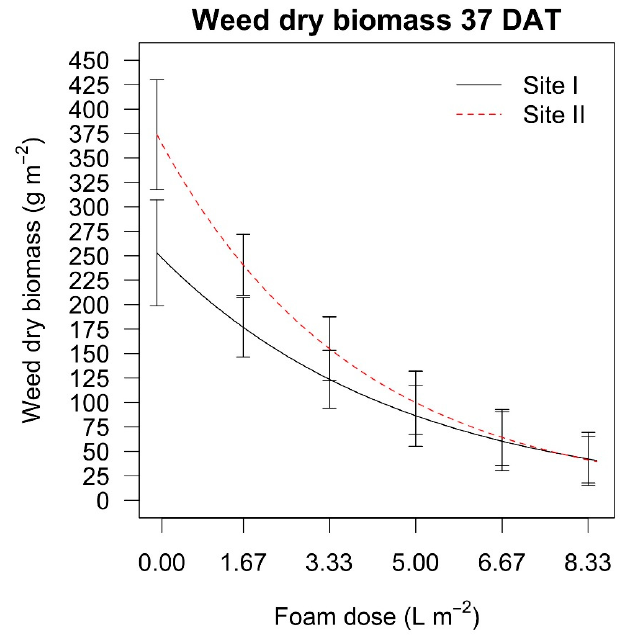
Figure 8. Exponential decay curves with 95% confidence interval bars of weed dry biomass collected 37 days after the treatment (37 DAT) as affected by the foam dose (0, 1.67, 3.33, 5.00, 6.67 and 8.33 L m -2 , respectively) and the site in the Taraxacum officinale (Weber) and Plantago lanceolata (L.) infested field experiment. The parameters and standard errors of the non-linear regression curves (Equation (3)) are: d = 253.02 (±26.659) and 373.88 (±27.614) for Site I and II, respectively; e = 4.66 (±0.957) and 3.78 (±0.543) for Site I and II, respectively. Table 8. Mean values and standard errors (SE) estimated from the exponential decay model (Equation (3)) of the weed dry biomass as affected by the different foam doses (0, 1.67, 3.33, 5.00, 6.67 and 8.33 L m -2 , respectively) and the site at 37 days after the treatment in the Taraxacum officinale (Weber) and Plantago lanceolata (L.) infested field experiment. The non-linear regression curves are plotted in Figure 8. Foam Dose (L m − 2 )